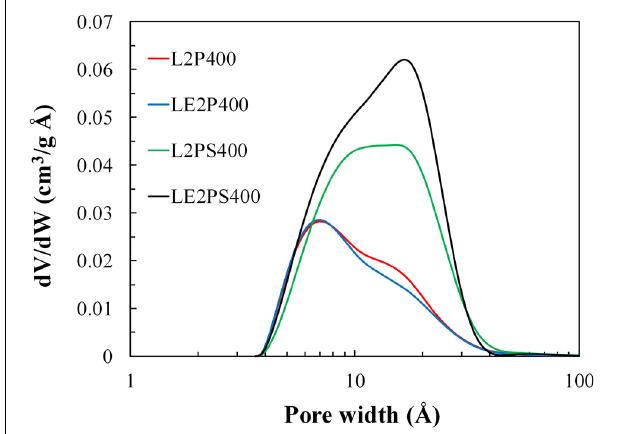
FIGURE 7 | Micropore size distribution of the different activated carbons obtained at 400 ◦ C and with H 3 PO 4 to lignin mass ratio of 2.